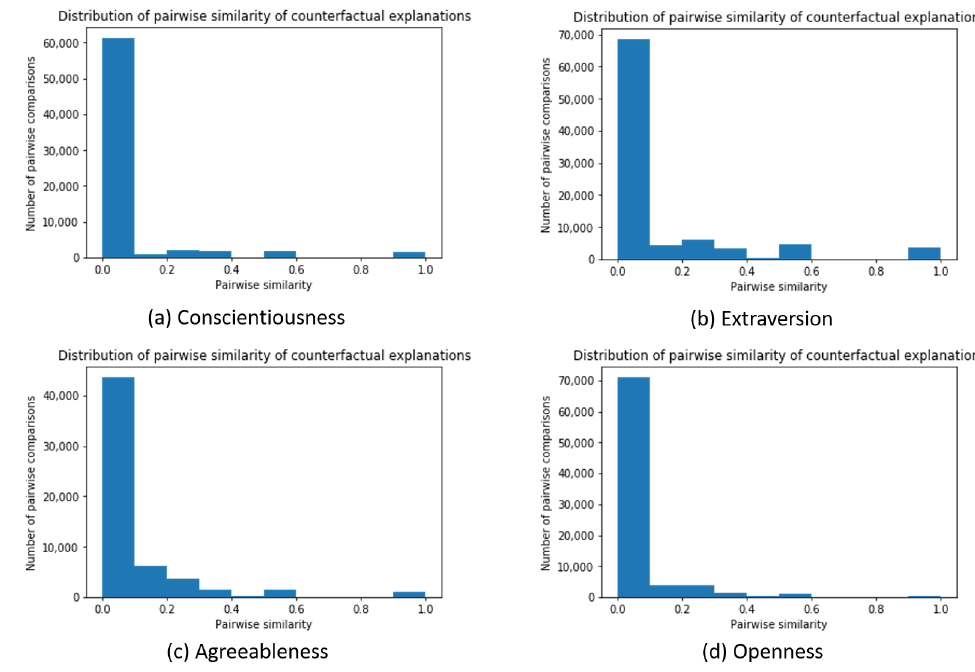
Figure A4. Distribution of pairwise similarity between counterfactual explanations for predicting ( a ) Conscientiousness, ( b ) Extraversion, ( c ) Agreeableness and ( d ) Openness. A value of 0 (resp., 1) indicates no (resp., perfect)